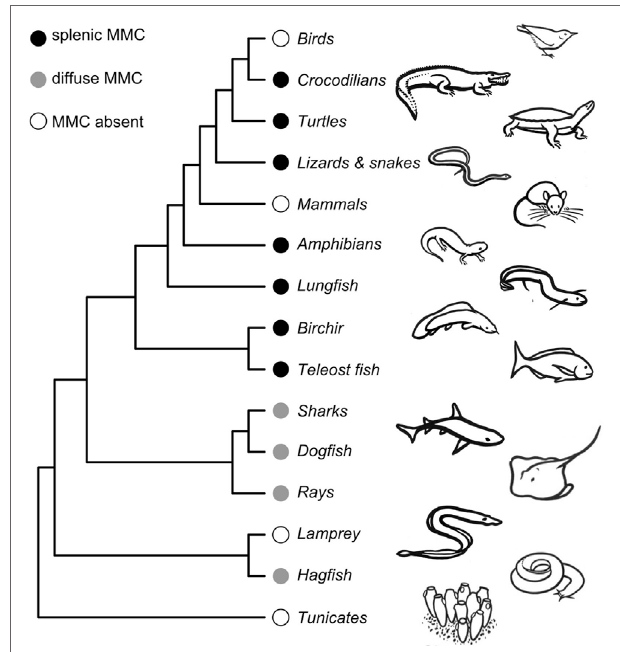
FigURe 2 | Phylogeny showing melanomacrophage center (MMC) gains and losses across vertebrate species. Detailed phylogenies of fish, amphibian, and reptilian species can be found in Supplemental Material. The phylogeny is not time-calibrated and was plotted using the ape package in R (57), using a topology obtained from the OneZoom database (58). Drawings by Doreen J.